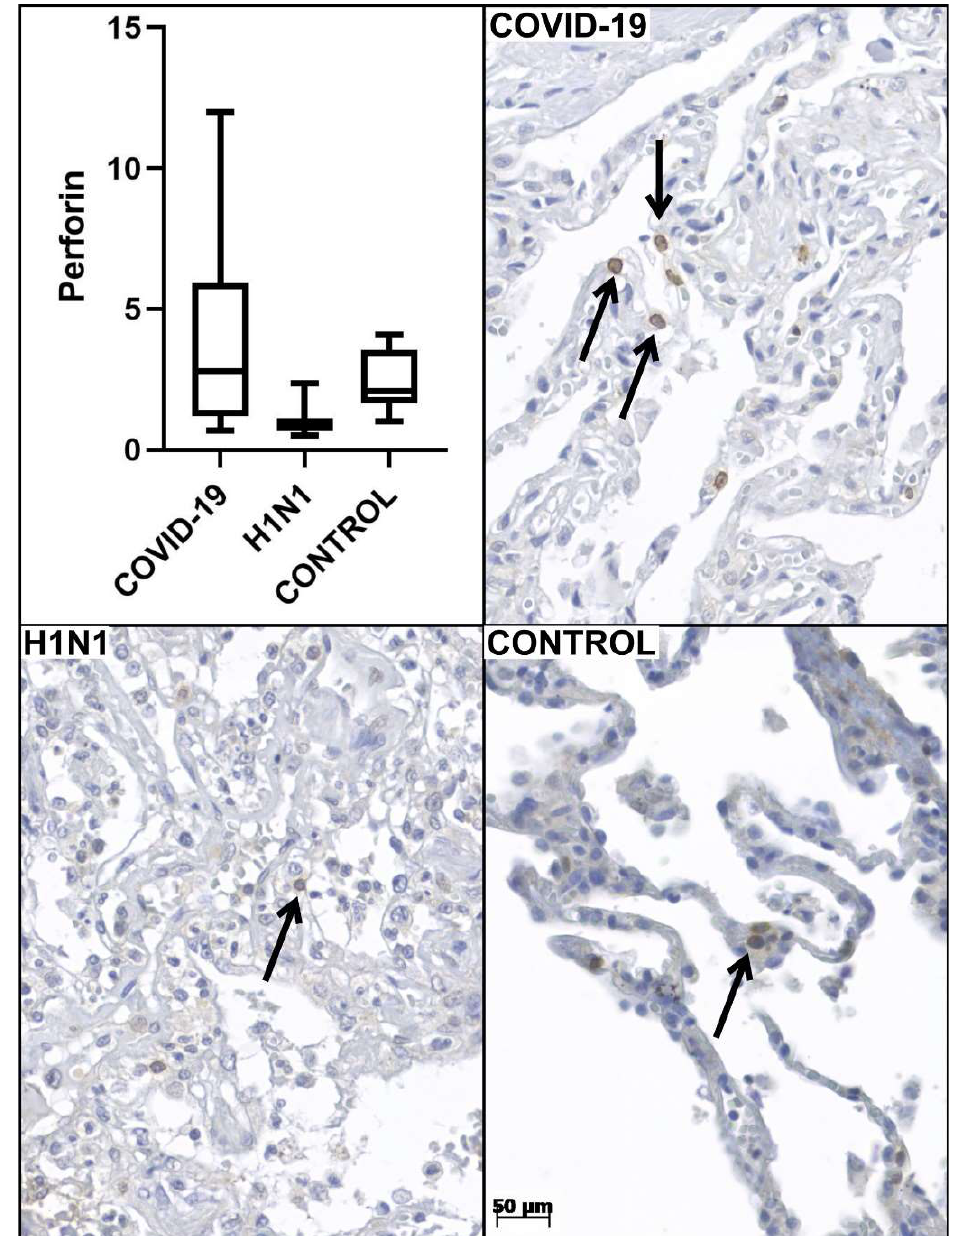
Figure 1. Graphics are showing tissue immunoexpression of perforin (number of perforin + cells per high-power fields—HPF) for COVID-19, H1N1, and CONTROL groups. Photomicrography shows T lymphocytes ( arrows ) expressing perforin in all three groups (40× HPF).